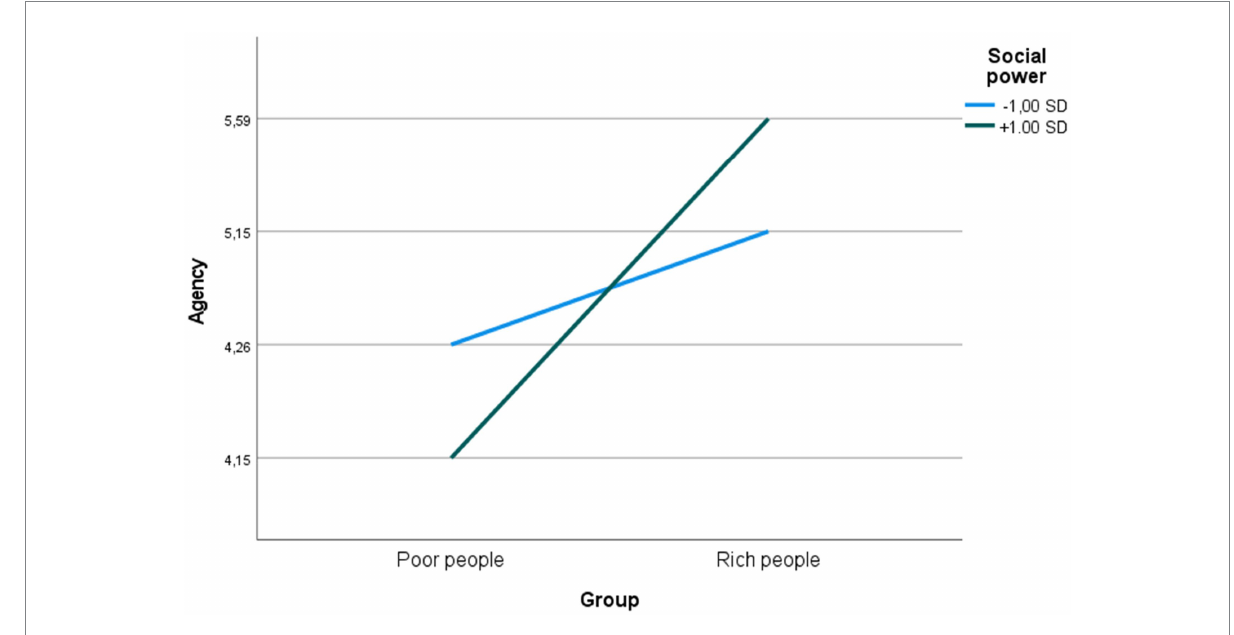
FIGURE 3 Predicted perceptions of agency at high and low levels of social